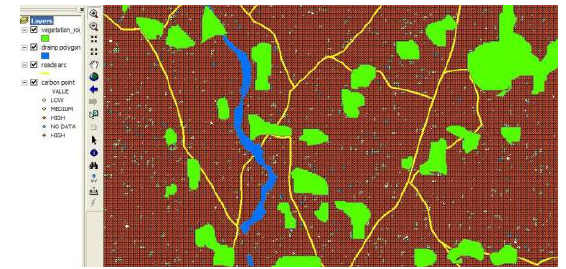
Fig 10 Calculated organic carbon from